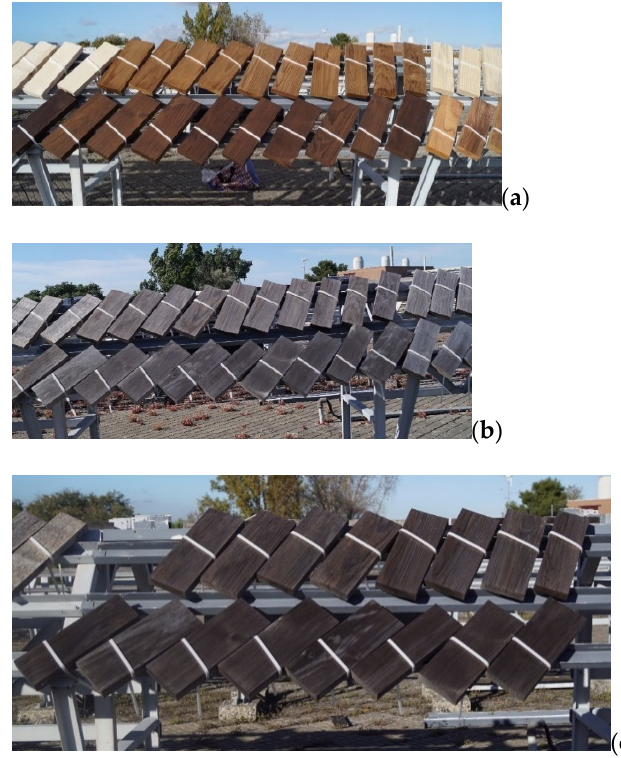
Figure 2. Pictures of color evolution during weathering exposure: ( a ) 0 months of exposure; ( b ) 9 months of exposure; ( c ) 12 months of exposure. ( b ) 9 months of exposure; ( c ) 12 months of